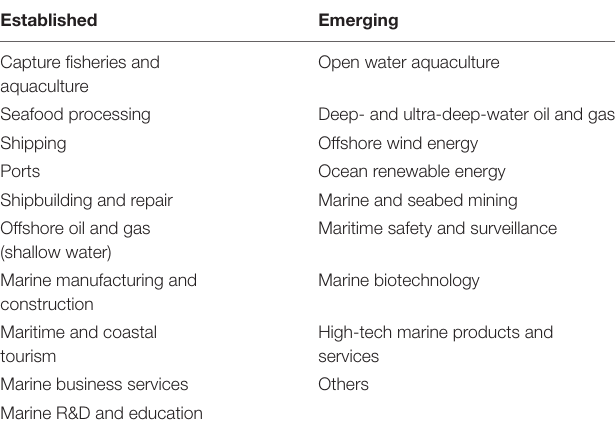
TABLE 1 | Established and emerging ocean-based industries (adapted from OECD, 2016).